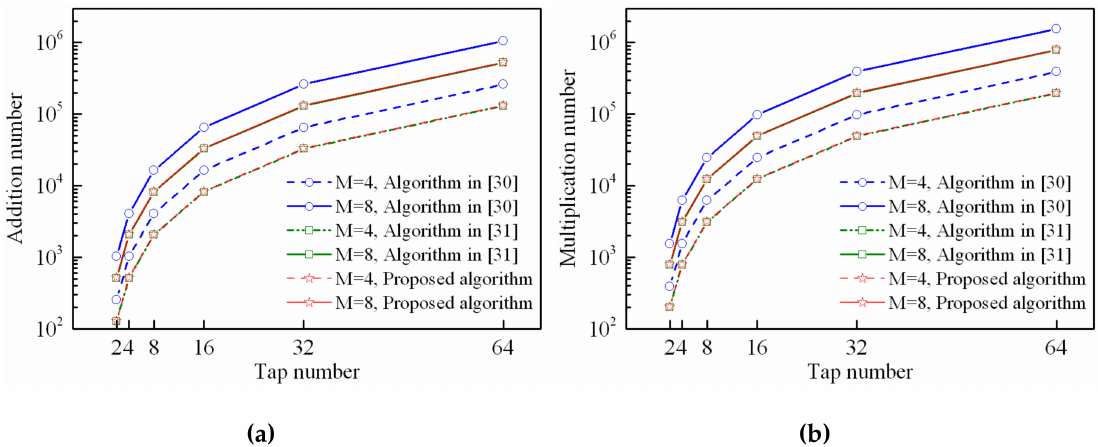
Figure 12. Computational complexity of the proposed STPAP beamforming algorithm and the STPAP algorithms based on the criterions in [30,31] when J = 2: ( a ) addition number; ( b ) multiplication